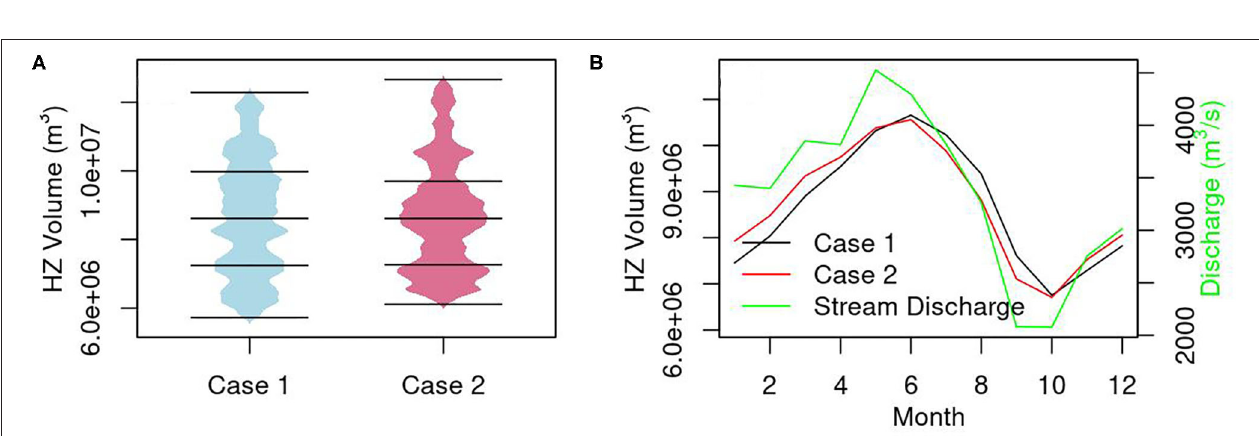
FIGURE 3 | Violin plots of temporal hydrologic exchange flow rate from PFLOTRAN in the lateral (A) and vertical (B) direction and seasonal hydrologic exchange flow rate and stream discharge in the lateral (C) and vertical (D) direction. The river gains water for the positive flow.